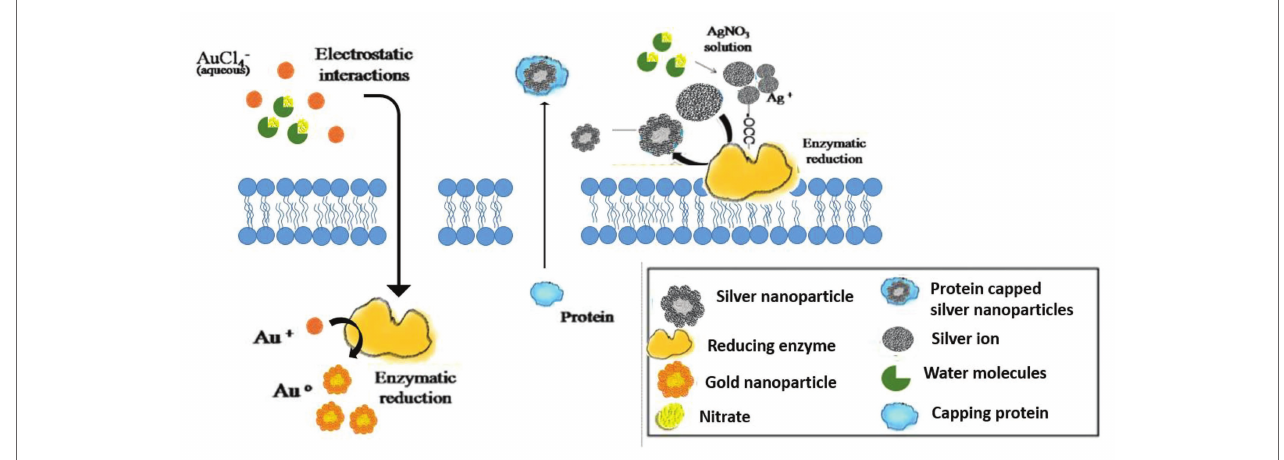
FIGURE 1 | Microbial enzymes in bio reduction of metal, metalloid, and nonmetal ions to